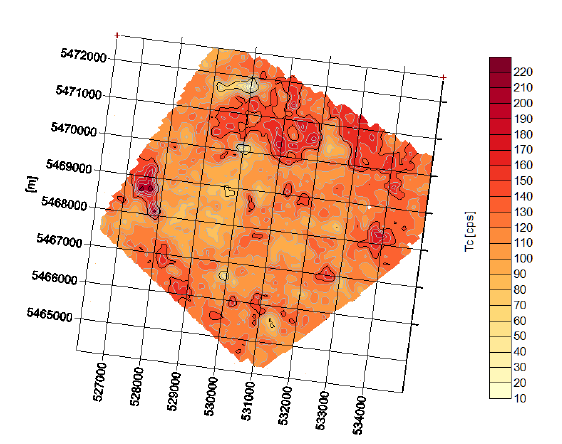
Figure 20. The map of total gamma activity. The air borne gamma spectrometry on a promising area for deep underground repository in